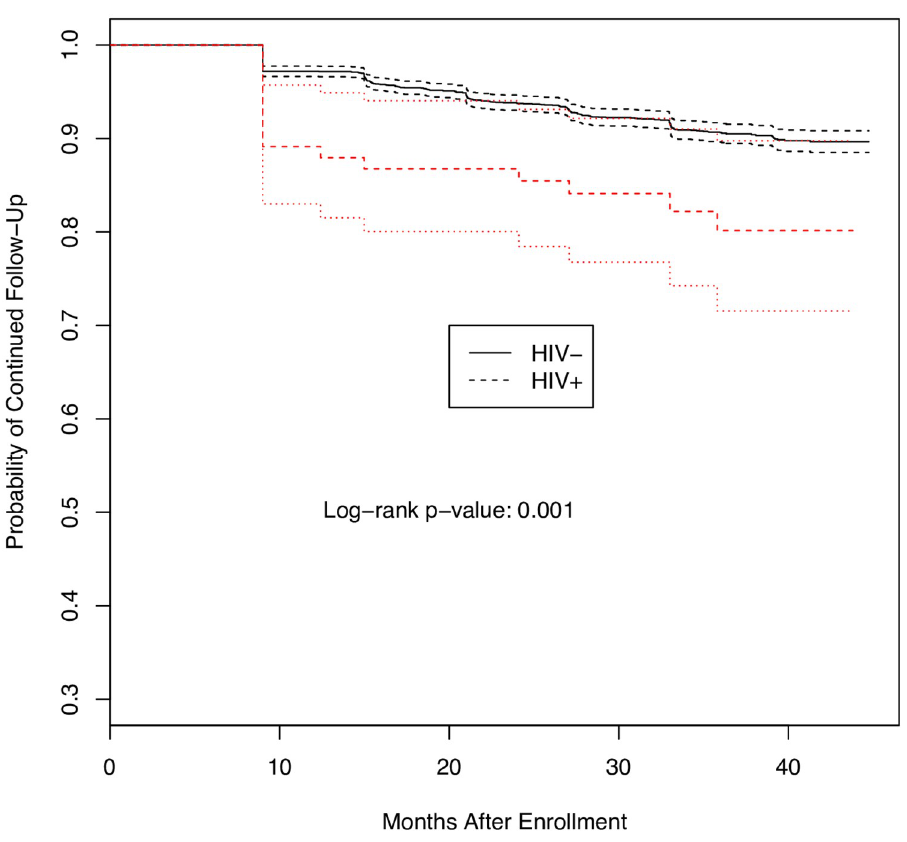
Fig 2. Probability of loss to follow-up over time for participants in PREVAIL III by HIV status.